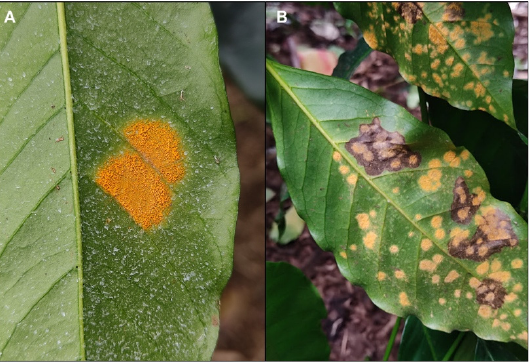
Figure 3. Symptoms of CLR infection on the lower leaf surface: active sporulation seen as powdery orange lesions ( A ); as the disease progresses severity increases, and tissue necrosis occurs ( B ). Photos by Luis F. Aristizábal.